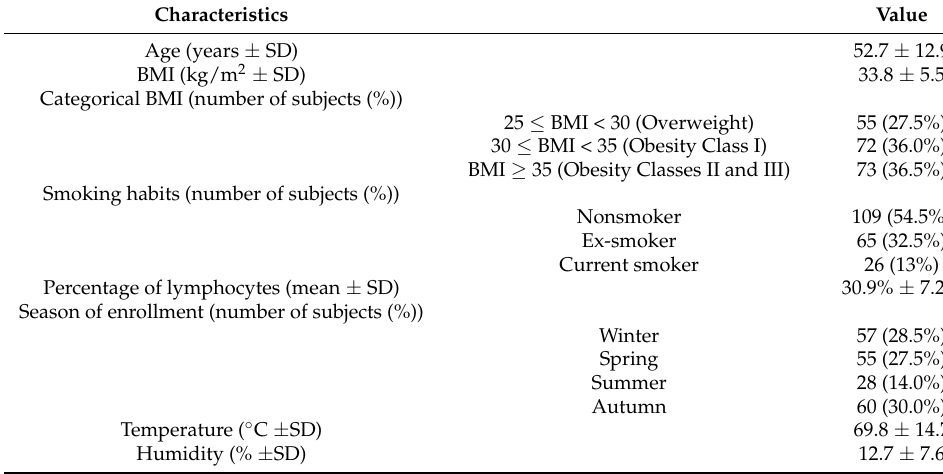
Table 2. Characteristics of the study participants.